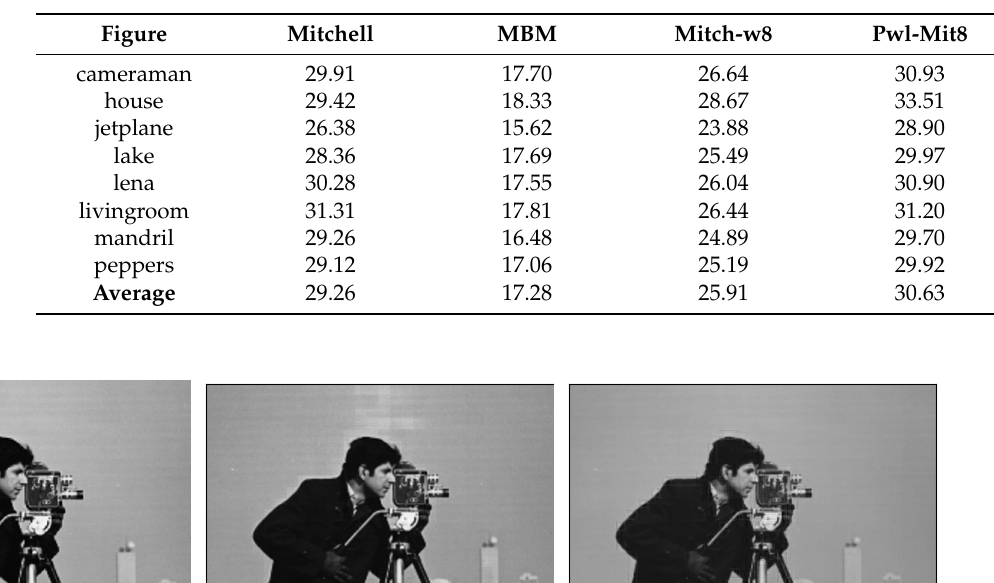
Table 3. Peak signal-to-noise ratio comparison result